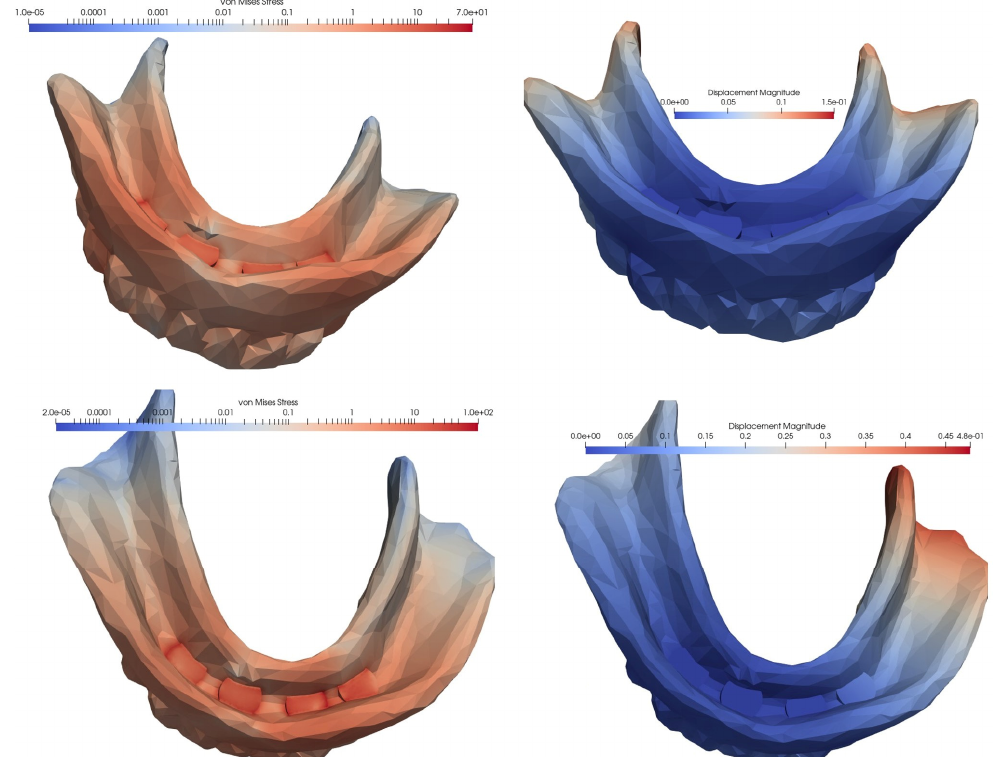
Figure 6. The von Mises stresses and displacements generated by the bilateral loading of an overdenture on four interforaminally inserted MDIs ( top ), compared to the loss of a distal implant ( bottom ).